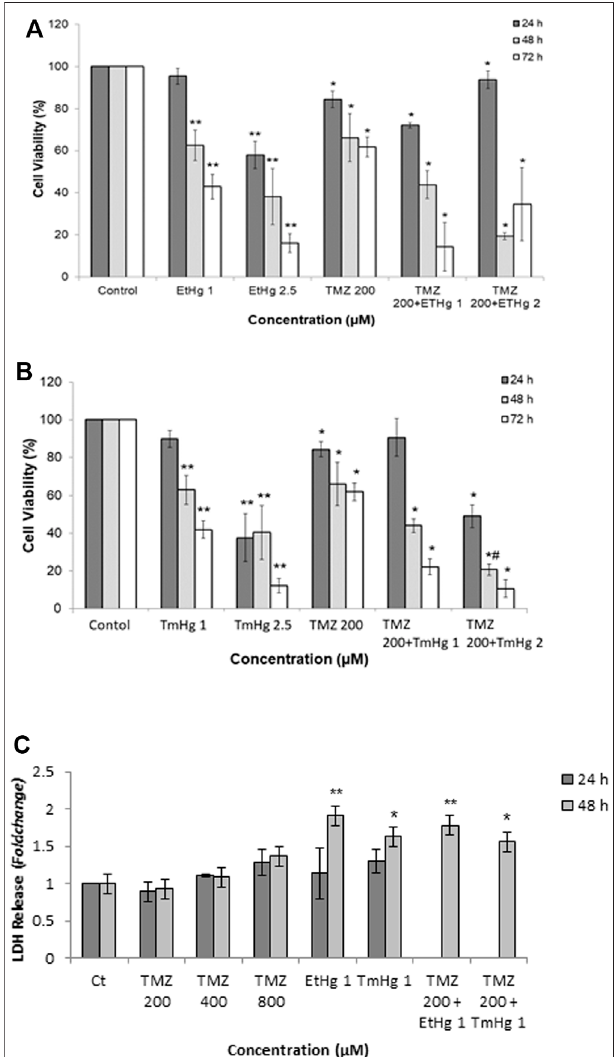
FIGURE 1 | Comparison of cytotoxicity exerted on glioblastoma by mercury(TmHgandEtHg)andTMZaloneandinco-exposurewithmercurials. Cell viability (A, B) and LDH release (C) of GL261 cells were tested upon exposuretodifferentconcentrationsofcompounds(EtHgandTmHg)for 24, 48, and 72 h. Cells were exposed to TMZ 200 µM and in co-exposure to 200 µM TMZ and 1 or 2 µM of EtHg/TmHg. Cell viability was performed by MTTassay (A,B) andLDHreleaseintotheculturemediumwasquanti fi ed (C) . Results are expressed relative to the non-treated control as the mean ± SEM of three to six different experiments. p p < 0.05, pp p < 0.01 from non-treated control, # p < 0.05 from TMZ 200